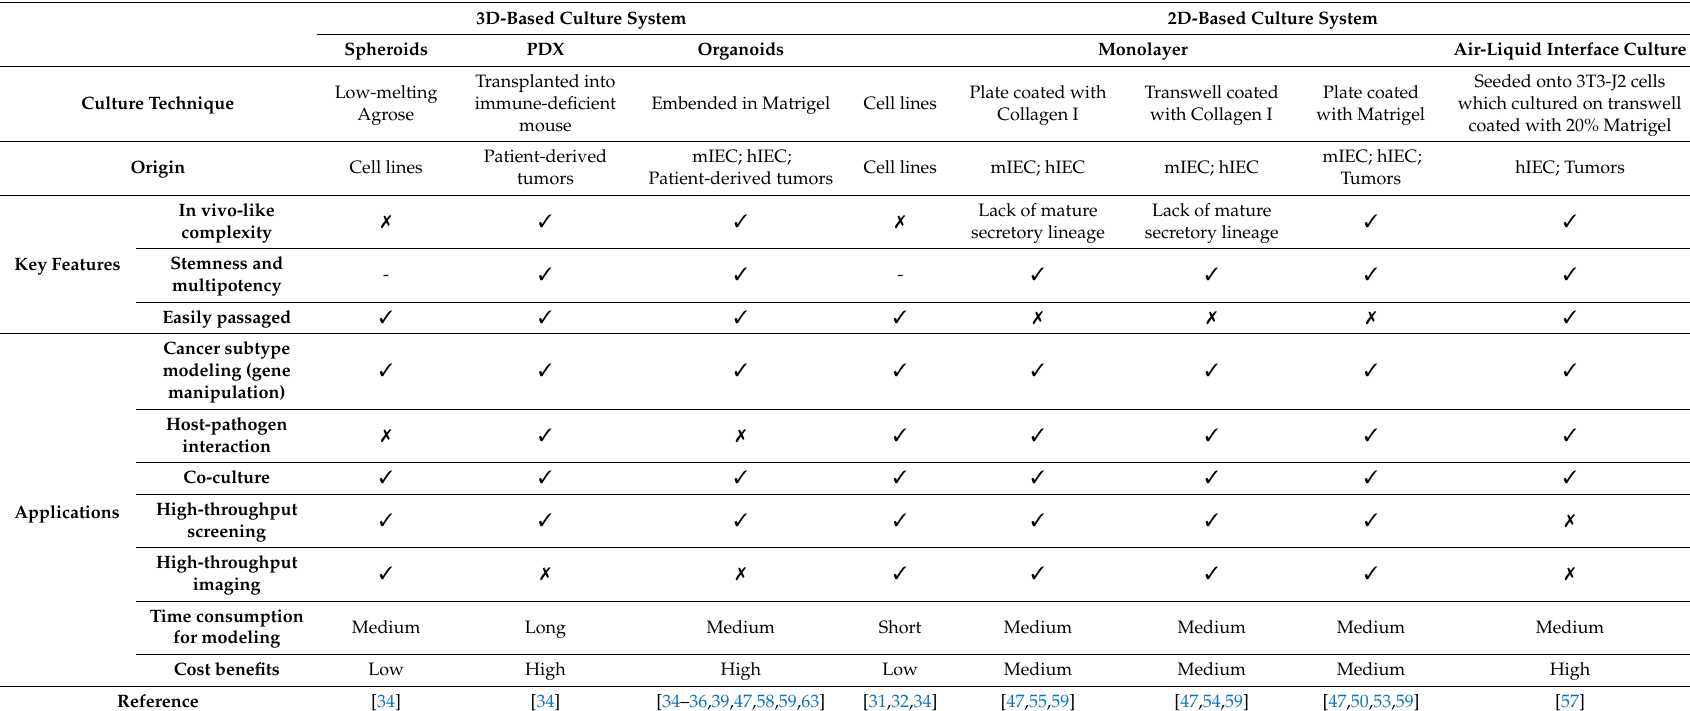
Table 1. Characteristics of the described preclinical cancer